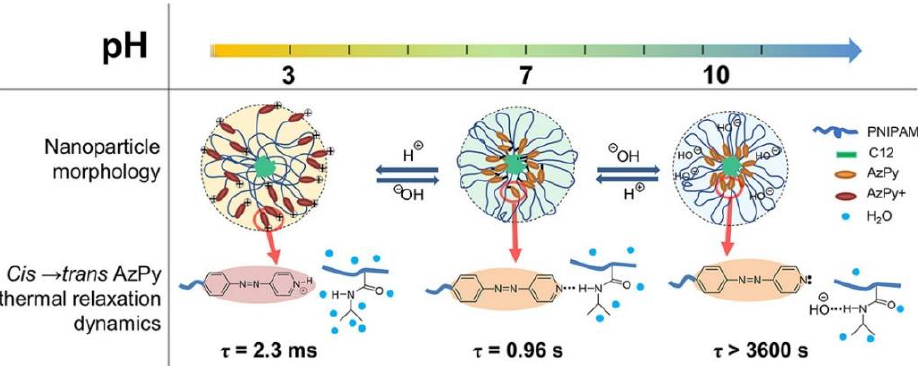
Figure 13. Schematic representation of C12-PN-AzPy nanoparticles dispersed in water of pH 3, 7, and 10 based on data from LS, FTIR, and 1 H NMR measurements and on the kinetics of the cis -to- trans thermal relaxation of azopyridine. Reprinted with permission from [24]. Copyright 2019, American Chemical Society.